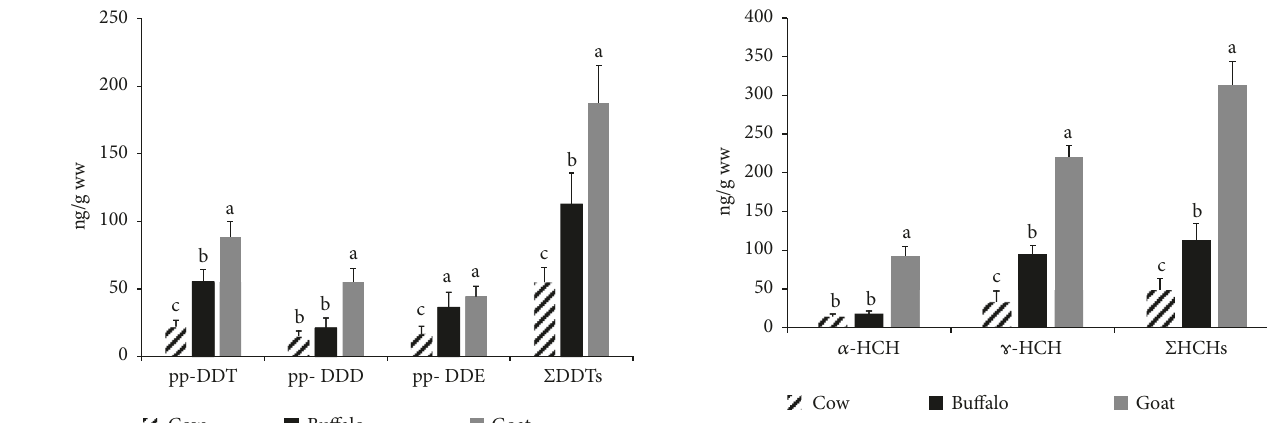
Figure 4: Total HCH and its isomers’ residues in the examined milk samples. Data represent mean ± SE (ng/g ww) for total HCH and its isomers in the examined milk samples from different animal species (n=20 each). Columns that carry different superscript letter among the same chemical are significantly different at p <